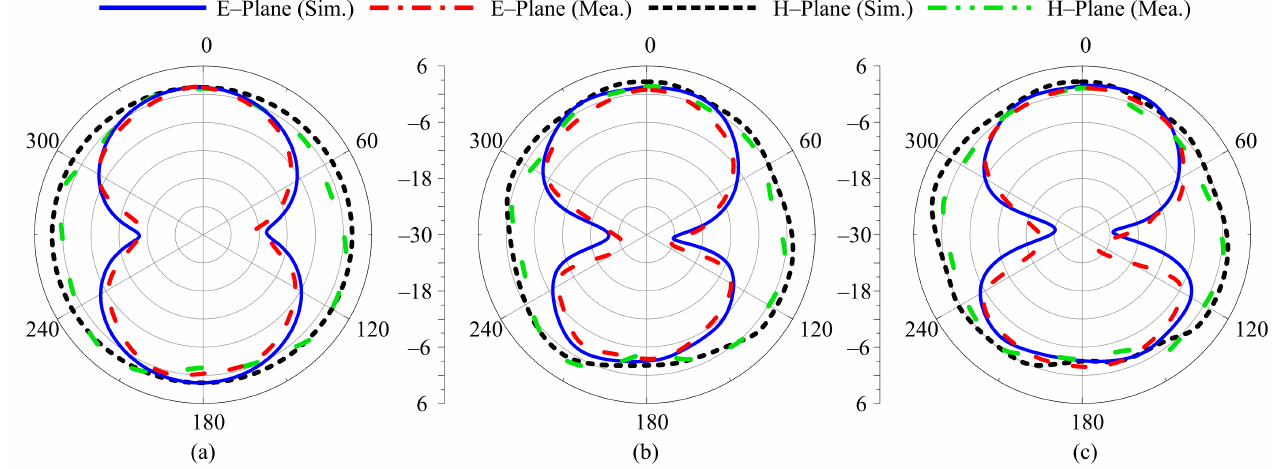
Figure 12. Simulated and measured radiation pattern of proposed antenna at 3.5 GHz for